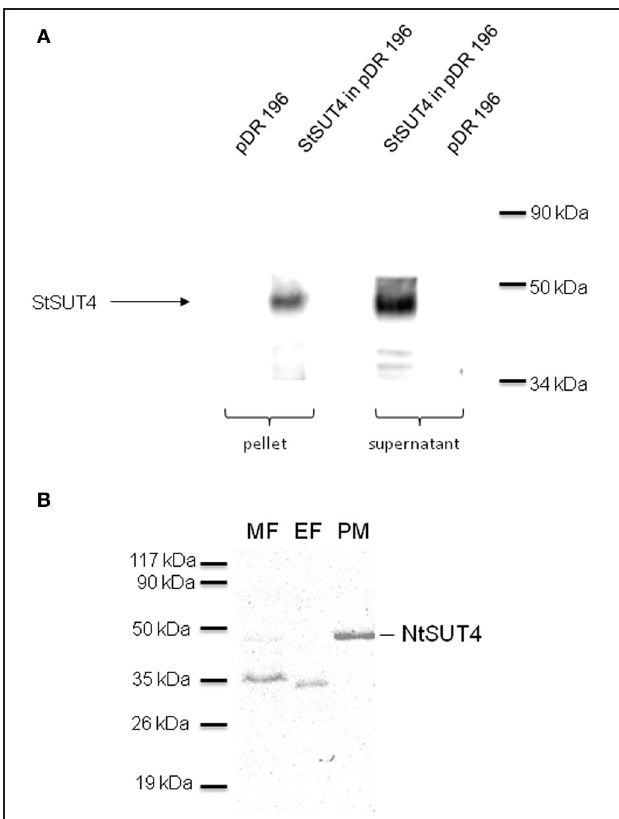
FIGURE 2 | Localization of StSUT4-GFP in stably transformed potato plants. Solanum tuberosum andigena has been transformed with StSUT4-GFP in pCK205 used previously for transient transformation (Chincinska et al., 2008). (A) StSUT4-GFP in young developing sink leaves. (B) Same picture as shown in (A) overlaid with chlorophyll autofluorescence. Arrows mark newly formed cell walls. Epidermis cells undergoing actively cell division. (C) StSUT4-GFP expression in mature source leaves is mainly restricted to guard cells. Arrows mark intracellular fluorescently labeled structures. (D) Same area as shown in (C) overlaid with chlorophyll autofluorescence indicating plastid localization. Note that GFP fluorescence is detectable outside of chloroplasts. (E–G) Guard cells of source leaves showing StSUT4-GFP fluorescence in the periphery of the cells, but sparing the region where the nucleus is localized (arrow) arguing for vacuolar